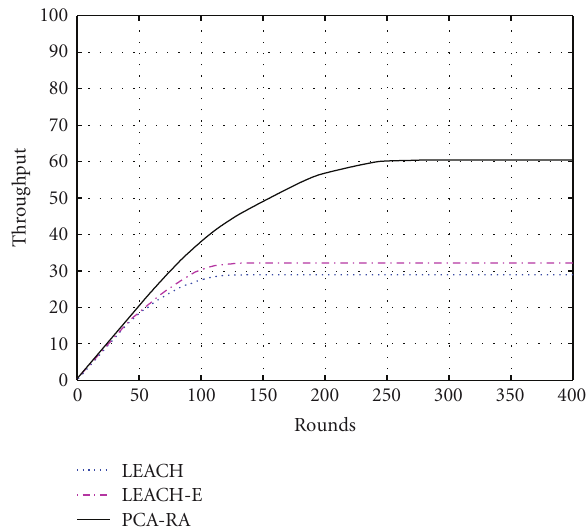
Figure 8: Throughput using LEACH, LEACH-E, and PCA-RA. Table 2: A numerical